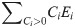
Mechanism of temperature compensation.(a) Accumulation of CiEi with Ci > 0 plotted against that with Ci < 0 for 398 different TCO realizations in the 35 best TCO topologies. The sums ∑Ci>0CiEi and ∑Ci<0CiEi are averaged over the examined temperature range and plotted in logarithmic scale with an inverted horizontal axis. (b) The mean CiEis corresponding to the Ci~T dependencies in Fig 4c1. (c) The mean CiEis corresponding to the Ci~T dependencies in Fig 4c2. The averages were calculated over the temperature range [283K, 303K].